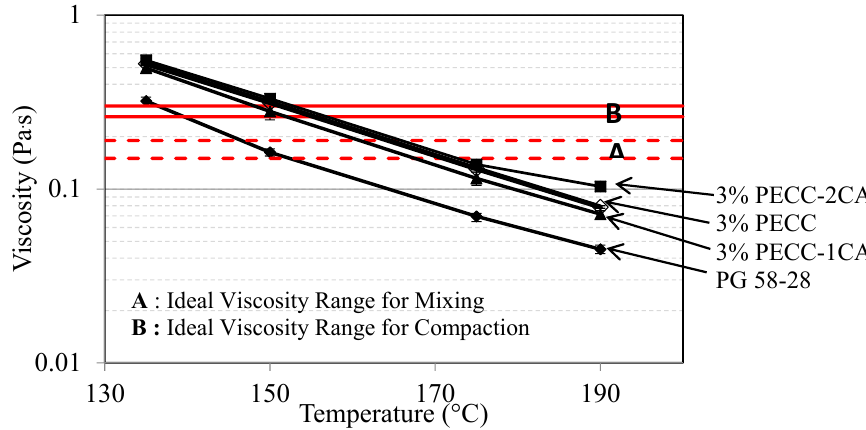
Figure 6. Modified Asphalt Binder Viscosity at Low Modifier Percentage.